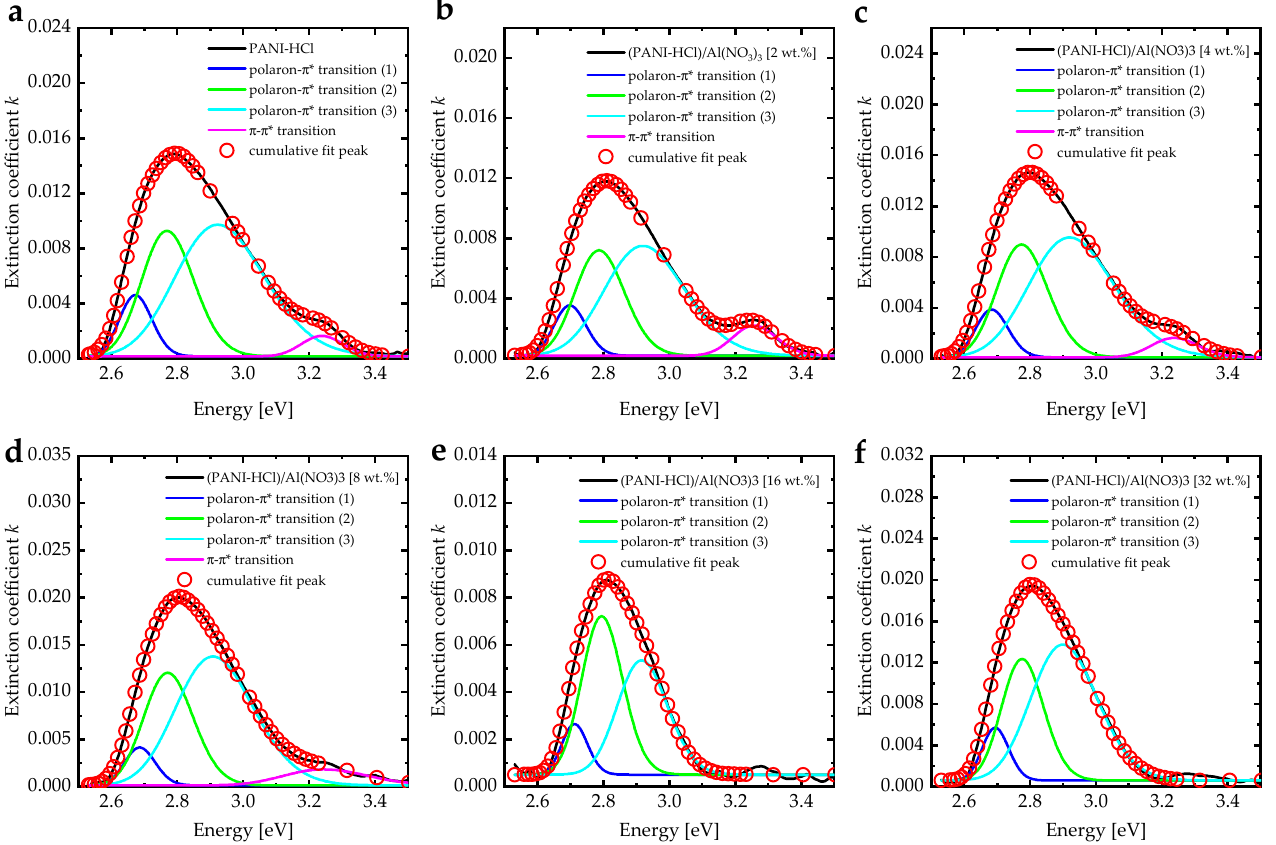
Figure 7. The extinction coefficient band de-convoluted by fitting the spectral envelope to four Gaussian peaks of (PANI-HCl)/Al(NO 3 ) 3 complex composite films with varying Al(NO 3 ) 3 concentrations: ( a ) 0, ( b ) 2, ( c ) 4, ( d ) 8, ( e ) 16, and ( f ) 32 wt.%. The refractive index values ( n ) can be calculated using 𝑛 = (1 + 𝑅) (1 − 𝑅⁄ ) + (cid:3493)(4𝑅 (1 − 𝑅) (cid:2870) ⁄ ) − 𝑘 (cid:2870) and fitted to the Cauchy model, which is given by n = A+B/ λ 2 , where A and B are constants [53]. The refractive index for the PANI-HCl film decreased from 2.55 to 1.54 as the incident photon wavelength increased from 250 nm to 700 nm (Figure 6d). Moreover, increasing the Al(NO 3 ) 3 concentration in (PANI-HCl)/Al(NO 3 ) 3 complex composite films increased the refractive index due to the interaction between Al 3+ ions and the PANI interaction that may increase the compositional density of the composite films [54]. Tauc plots were performed to investigate the bandgap energy of (PANI-HCl)/Al(NO 3 ) 3 complex composite films by plotting ( α h ν ) 2 versus h ν , according to the equation ( α h ν ) 2 = β (h ν − E g ) for direct band-gap semiconductors. All the films exhibited two bandgap energies; the first band-gap energy ( E g1 ) decreased from 3.40 eV to 3.01 eV, representing the π - π * electron transition within the benzenoid (B) ring, while the second